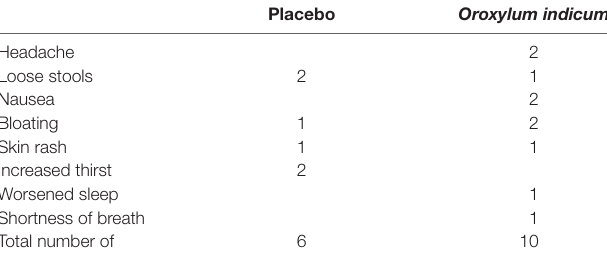
TABLE 7 | Frequency of self-reported adverse